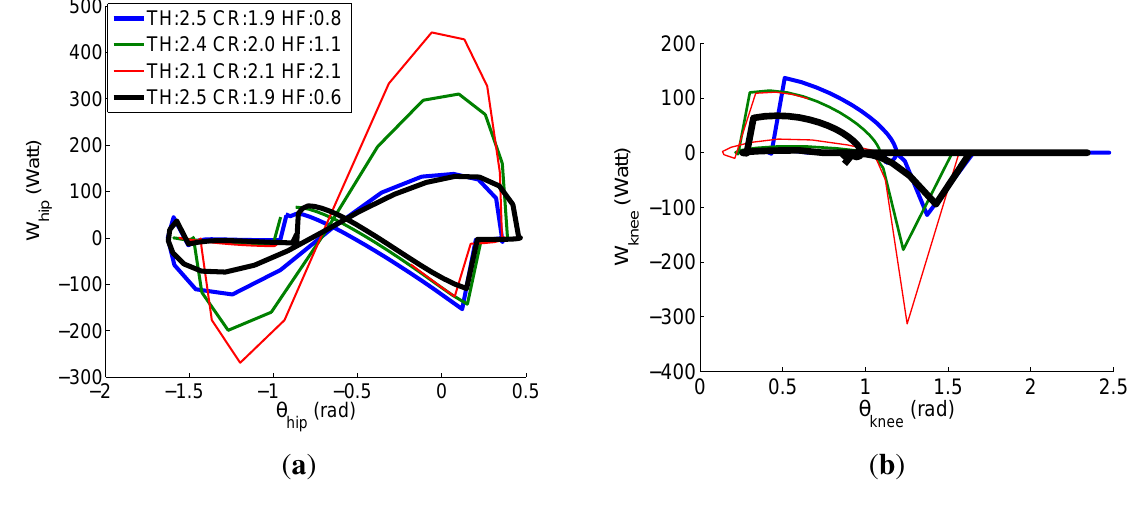
Figure 4. Iterative optimization of leg mass distribution by minimizing the power required at the joints. Convergence is shown in back thicker line for 2.5 kg, 1.9 kg and 0.6 kg at thigh (TH), crus (CR) and hoof (HF) respectively: ( a ) hip power for varying link masses; ( b ) knee power for varying link masses. Initial and intermediate values of the iteration are provided in the figure